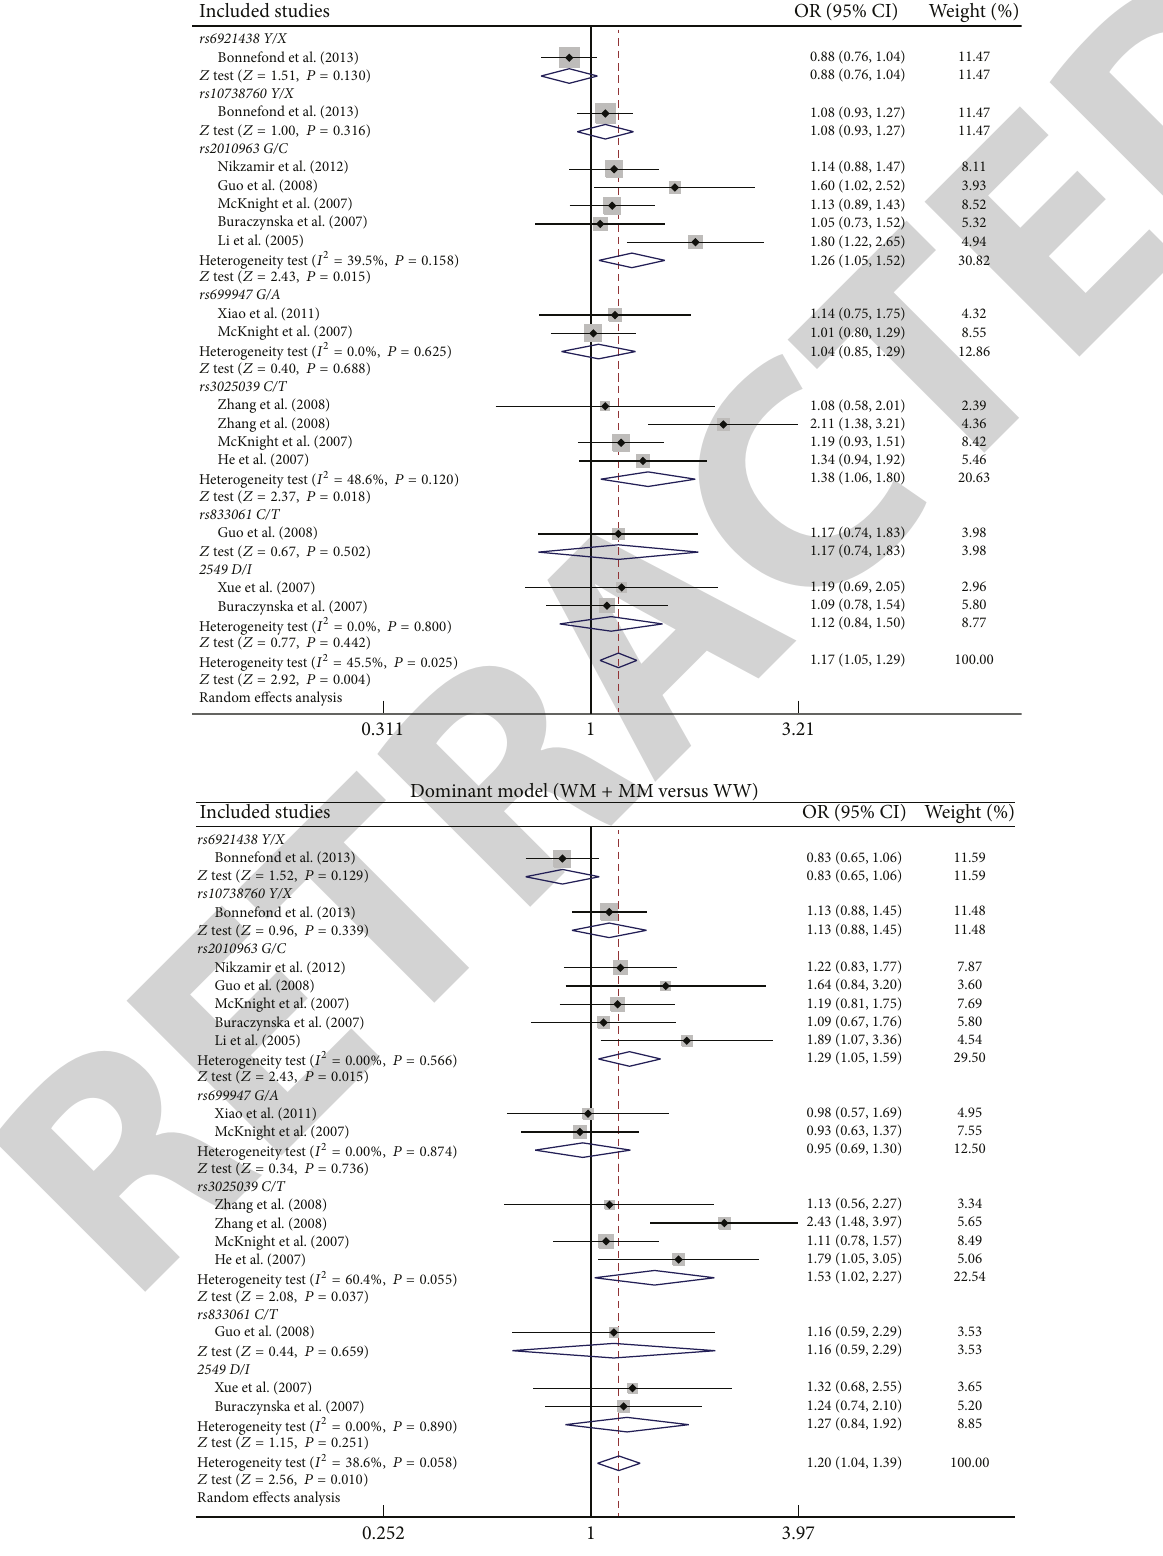
Figure 3: Forest plots for the relationships of VEGF genetic polymorphisms with the risk of diabetic nephropathy in patients with diabetes mellitus under the allele and dominant